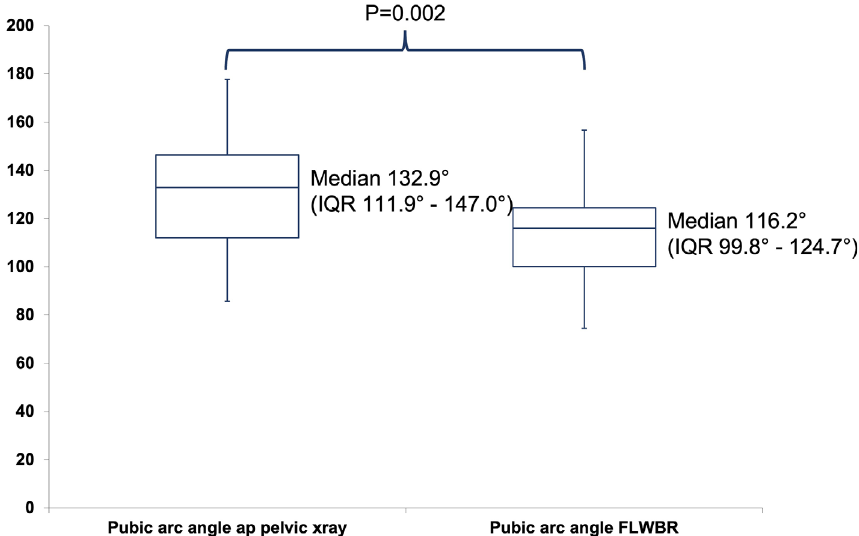
Figure 4. Box plot depicting the pubic-arc angle (subpubic angle) measured on conventional ap pelvic radiographs and full-length weight- bearing